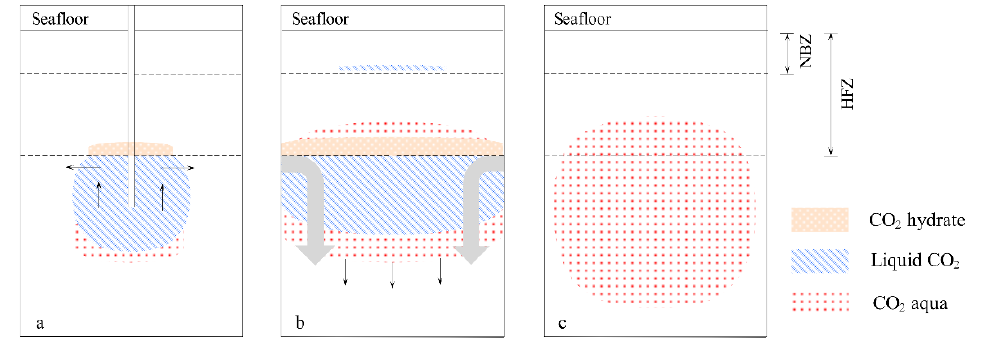
Figure 5. The long-term evolution of the injected CO 2 in deep-sea sediments (modified from [104]).